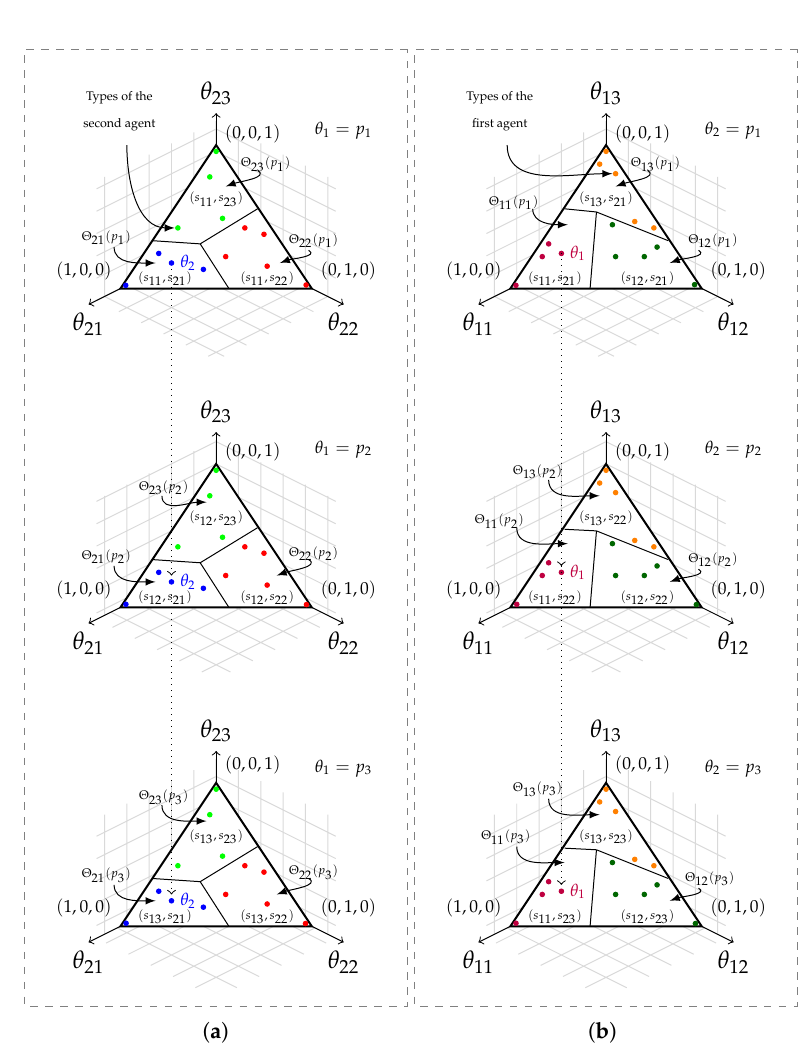
Figure 4. The partitioning of Θ b in a two-agent multigame with three games which shows that the multigame has a pure ex post NE. The types of each agent in the three partitioning of its type space are shown in three different